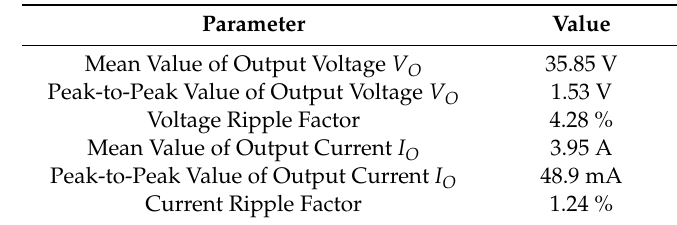
Table 3. Measured output voltage ripple and current ripple of the presented LED streetlight driver at a utility line voltage of 220V.